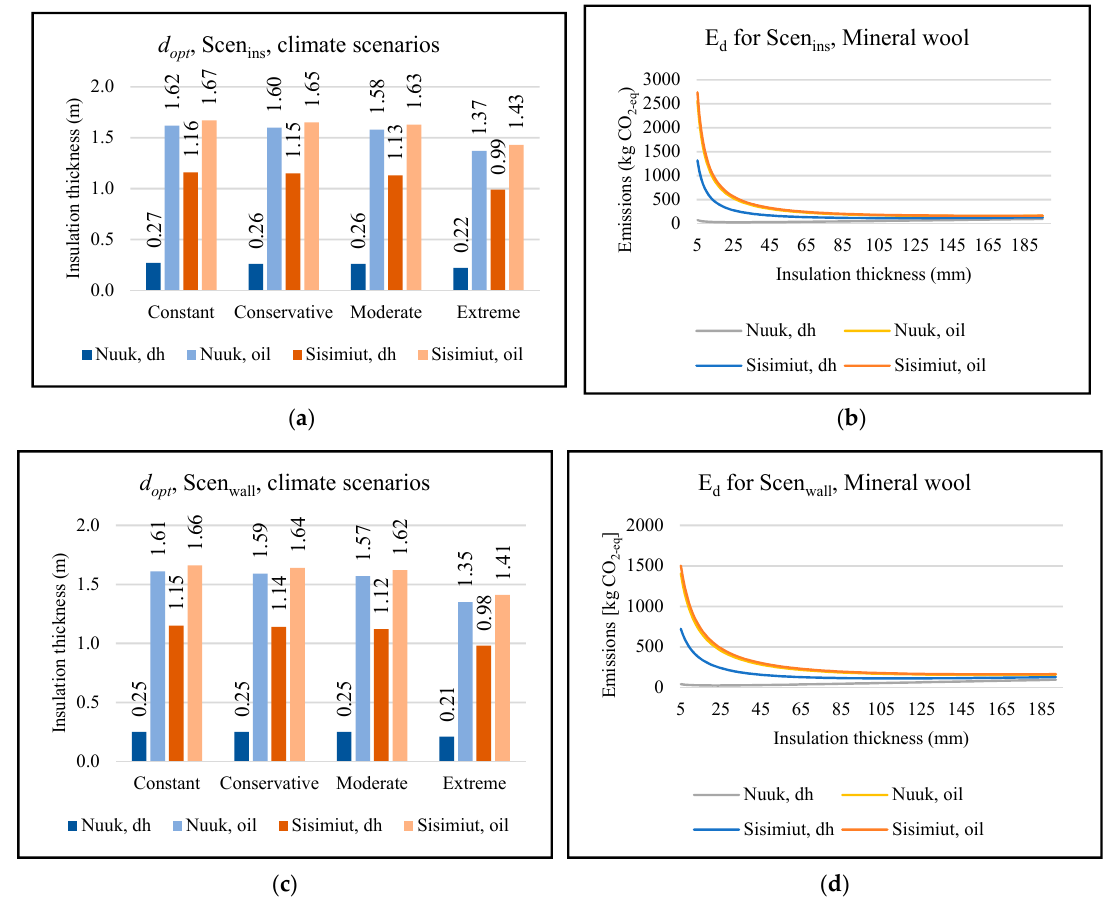
Figure 3. Graphs presenting some results from ITO. ( a , b ) are for Scen ins , while graphs ( c , d ) are for Scen wall . ( a , d ) consider climate scenarios for dh and oil heating in Nuuk and Sisimiut, while ( b ) and ( d ) presents the development of emissions at different thicknesses for mineral wool in Nuuk and Sisimiut with constant climate. ESL = 60 years.